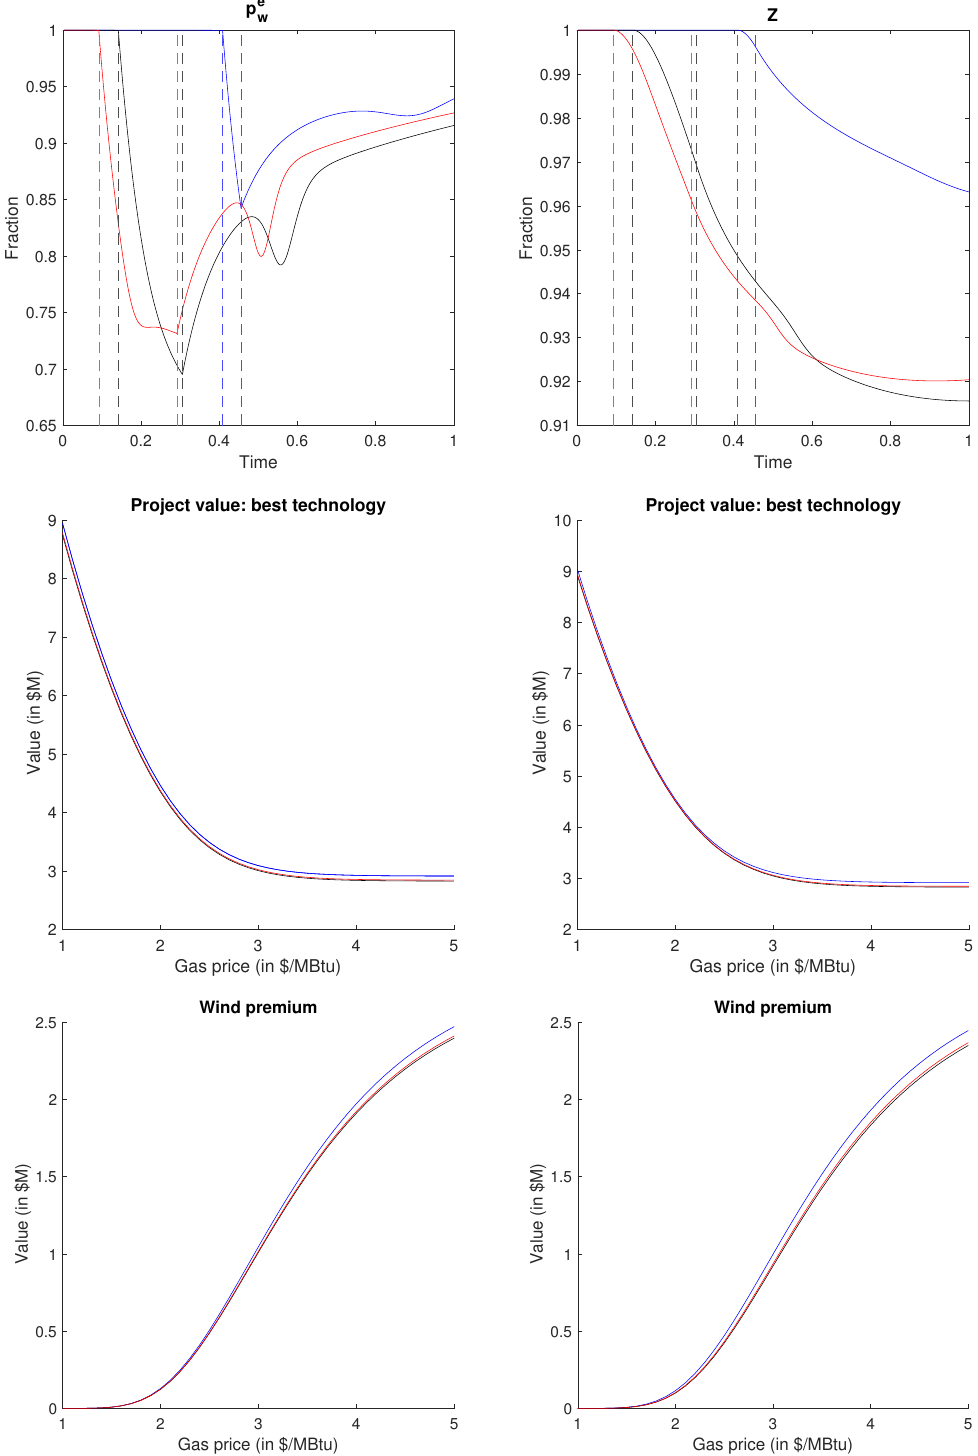
Figure 9. This figure displays the effects of β on the infectious population and pandemic factor (upper panels), project value (middle panels) and wind premium (lower panels) at t = 0 in case of low sensitivity of the gas price ( C = 0, left panels) and of high sensitivity ( C = 2.5, right panels). The value of X 0 is 50$/MWh. The values of β are: β = 0.8 (blue), β = 1.6 (black), β = 2.6 (red). Other parameter values are given in Table 1; the investment horizon is T = 1